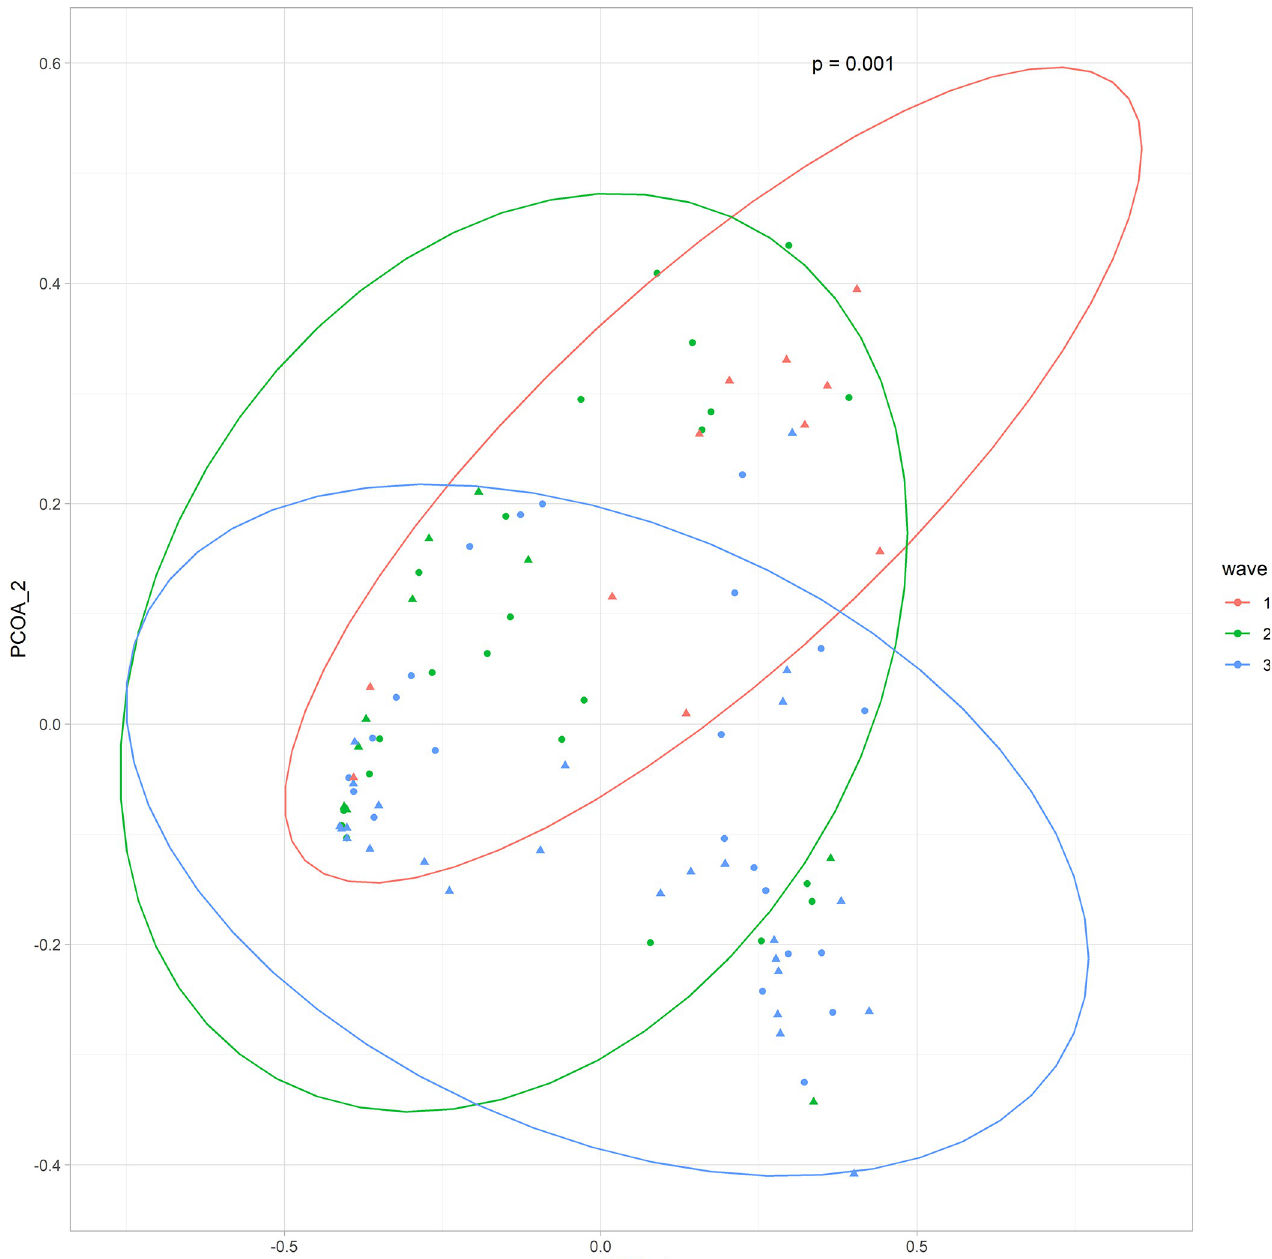
Fig 4. Beta diversity differences by collection date. PCoA plot for genus-level differences in the nasopharyngeal microbiome based on Bray-Curtis dissimilarity stratified by collection date. Circles indicate community-dwelling SARS-CoV-2-infected subjects and triangles indicate hospitalized SARS-CoV- 2-infected